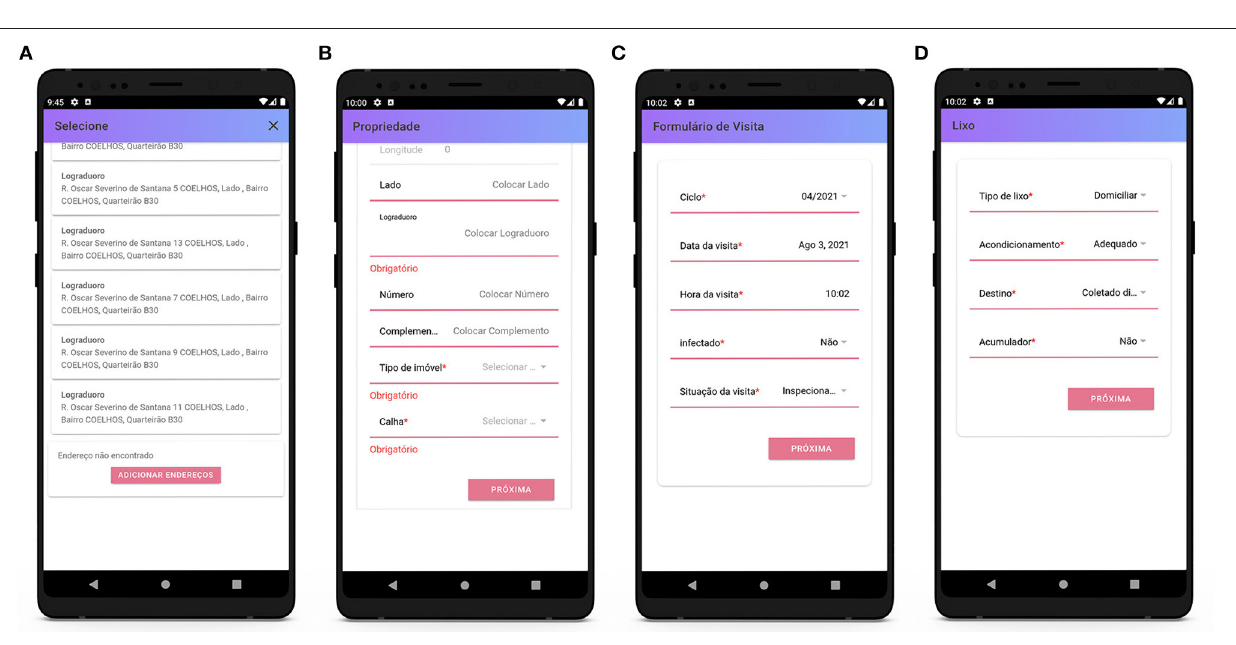
side is the interface between the system services and the